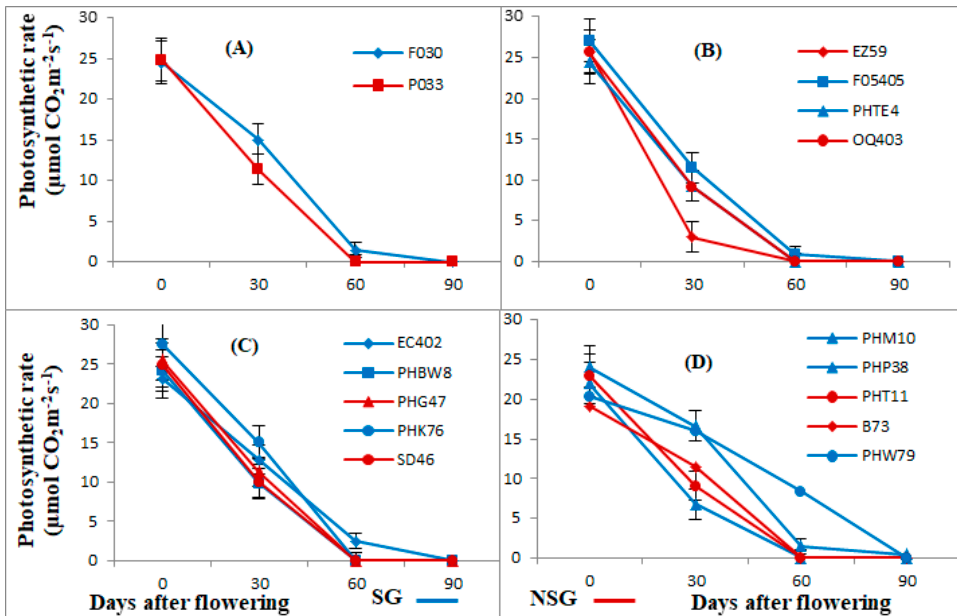
Figure 3. Photosynthetic rate of 16 maize inbred lines of four flowering groups from flowering time, evaluated in 2017 in two locations in Galicia. ( A , B , C , D ) present each flowering group: very early, early, medium, and late flowering, respectively; SG: stay-green genotype. NSG: non-stay-green. Means ± std error are presented.